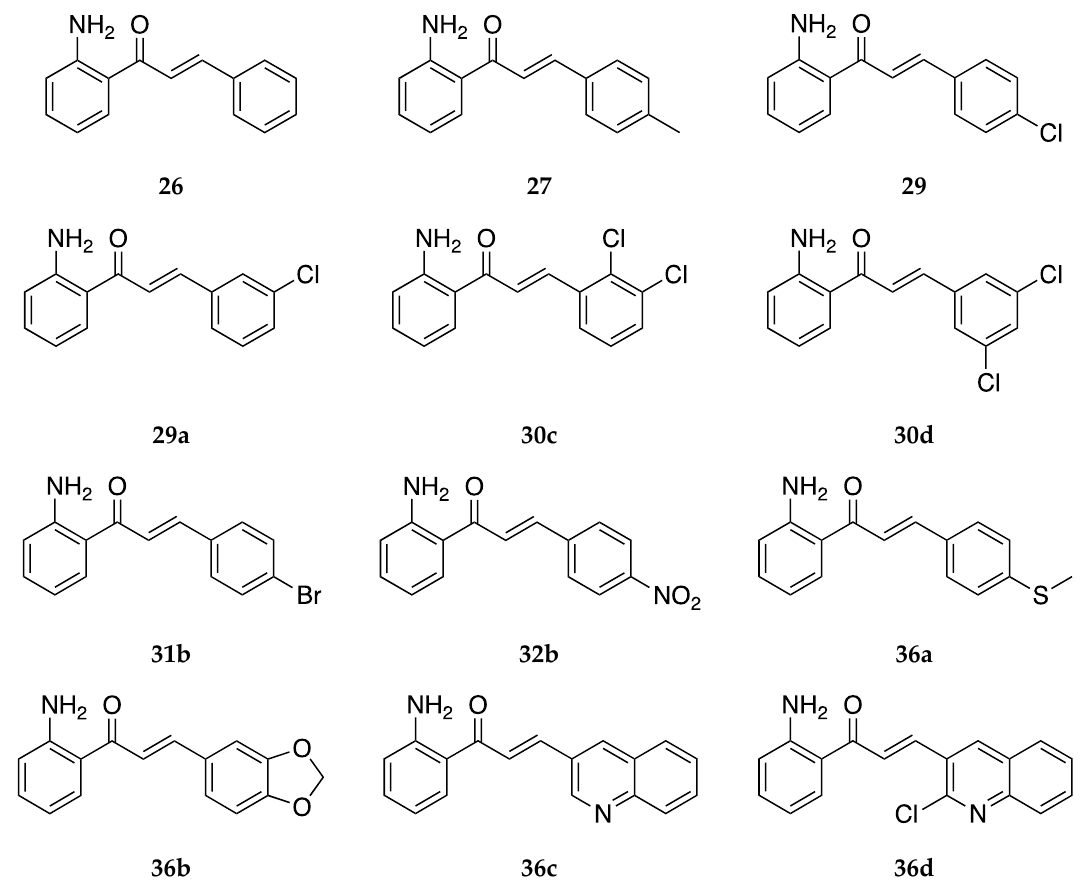
Figure 25. Chemical structures of derivatives of 2-aminochalcone with substitution on ring B.